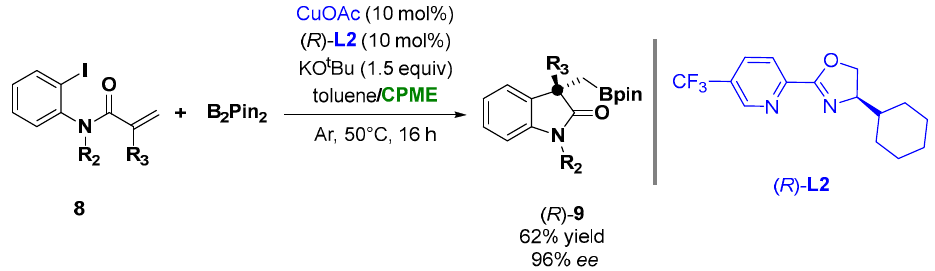
Figure 9. Synthesis of bortezomib through asymmetric Rh-catalyzed borylation of aa leucine ana- logue. Notably, in the asymmetric transfer hydrogenation (ATH) of α -alkoxy β -ketoesters ( 11 ) via dynamic kinetic resolution (DKR) involving a rhodium complex ( N -pentafluoro- phenylsulfonyl-DPEN-based tethered Rh(III) complex, 2-MeTHF was selected as a greener solvent to develop an environmentally sustainable procedure [19,84]. ATH/DKR access the desired enantiomerically enriched syn - α -alkoxy β -hydroxyesters ( 12 ) in high yields (68–97%), high levels of diastereocontrol (95:5 to 99:1 d.r.) and excellent enantiose- lectivities (>99% ee ) (Figure 10) [85].